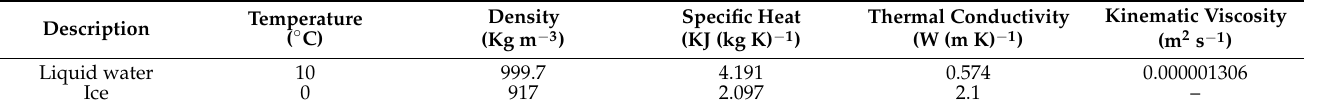
Table 3. Thermophysical property of water and ice in this model.